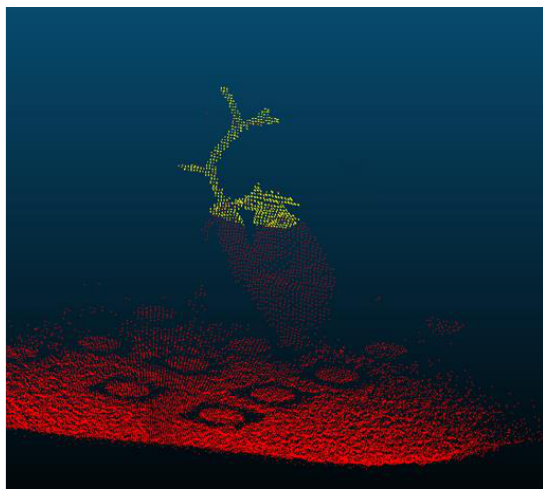
Figure 10. Antler point cloud after quality control and antler extraction.